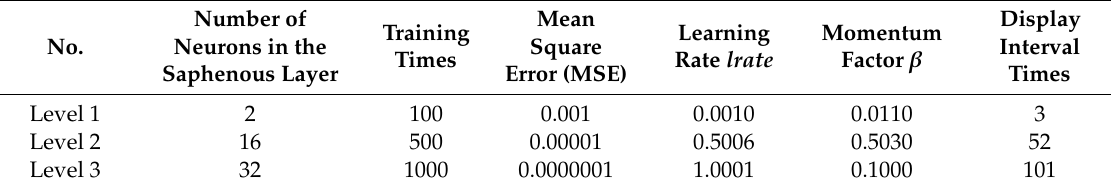
Table 8. The corresponding parameter values of each test level.